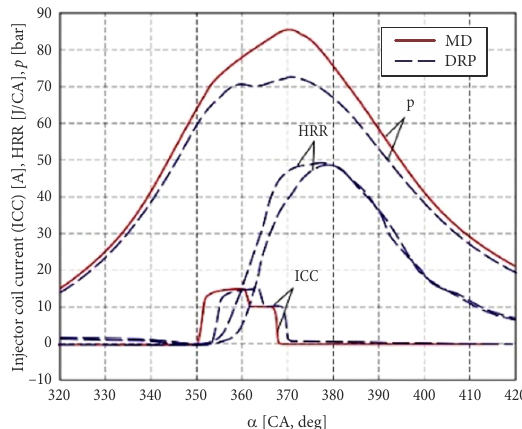
Figure 8. Injection current vs CA for MD and DRP